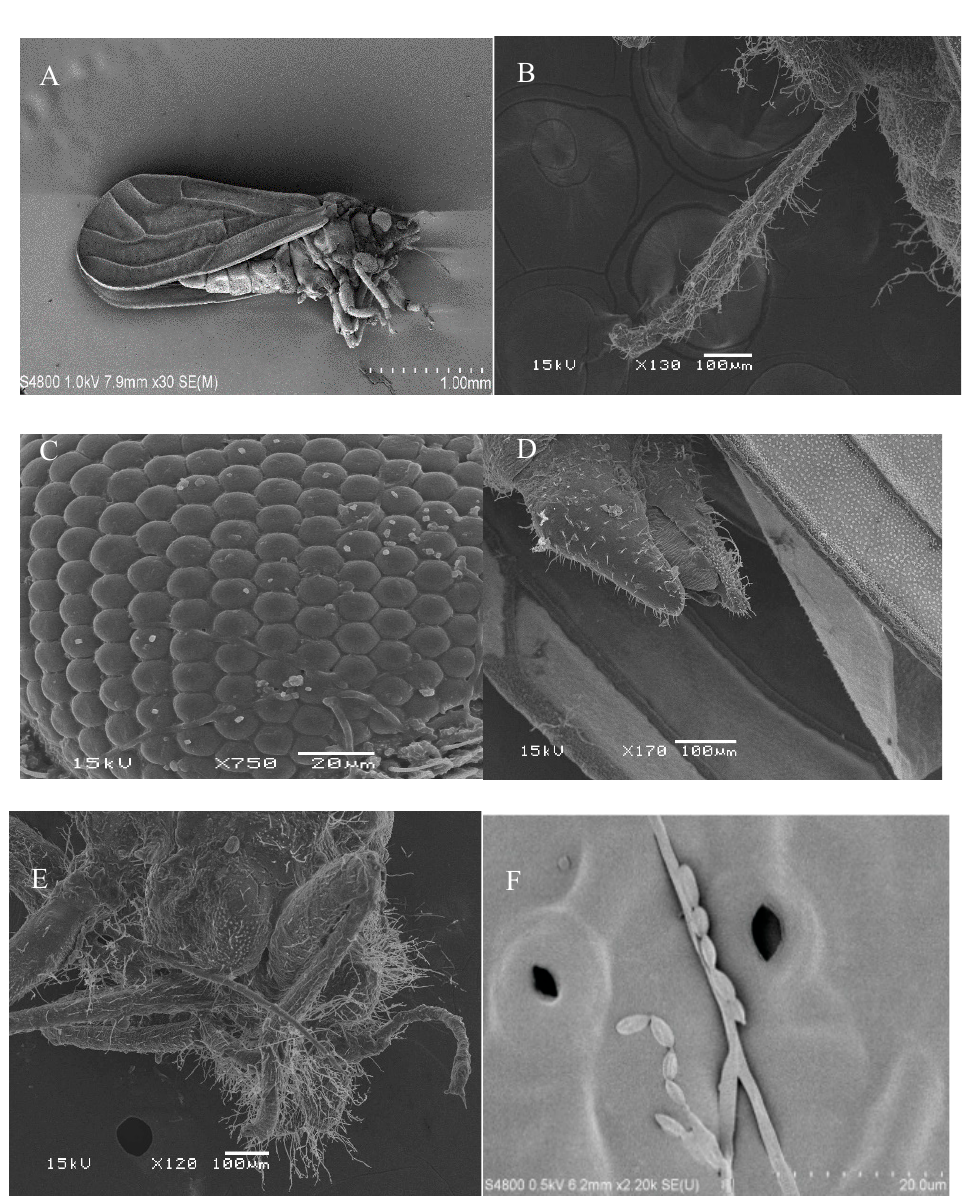
Figure 3. ( A ) SEM photomicrographs of Diaphorina citri uninfected adult; ( B ) Cja Apopka 97 hyphae growing on leg; ( C ) Cja hyphae growing on compound eyes; ( D ) Cja hyphal growth on genitalia; ( E ) head area covered with hyphae; ( F ) hyphae growing and forming conidia on the leaf surface.